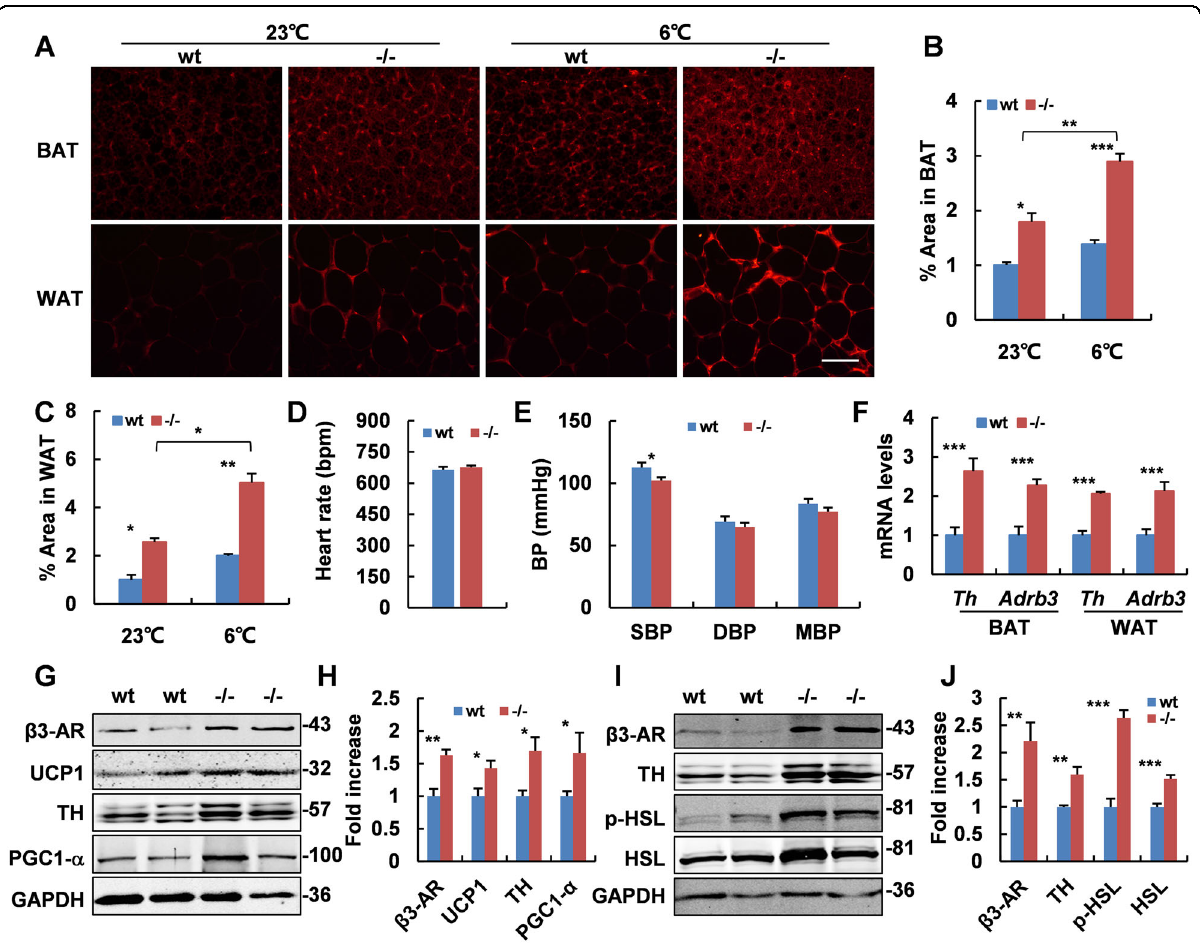
Fig. 5 SNS is activated in Adgra1 − / − male mice. A Representative images of IF of TH in BAT and WAT in room temperature and cold environment. Scale bar, 50 μ m. B Quantitative analysis of positive areas of TH in BAT, n = 5/group. C Quantitative analysis of positive areas of TH in WAT, n = 5/ group. D Heart rate in male mice of both genotypes, n = 9/group. E Blood pressure in male mice of both genotypes, n = 9/group. SBP systolic blood pressure, DBP diastolic blood pressure, MBP mean blood pressure. F mRNA levels of Th and Adrb3 in BAT and WAT assessed by real-time PCR, n = 5/ group. G Protein levels in BAT of Adgra1 − / − male and control mice analyzed by western blot. GAPDH is used as a loading control. H Quantitative analysis of relative intensities of proteins. n = 5/group. I Protein levels in WAT of Adgra1 − / − male and control mice analyzed by western blot. GAPDH is used as a loading control. J Quantitative analysis of relative intensities of proteins, n = 5/group. Western blot analysis using anti-TH antibodies detects a band at ~57 kDa, at a position where the TH is expected to migrate, with two nonspeci fi c bands running above and below. * p < 0.05, ** p < 0.01, *** p < 0.001 vs. controls. Data represent mean ±